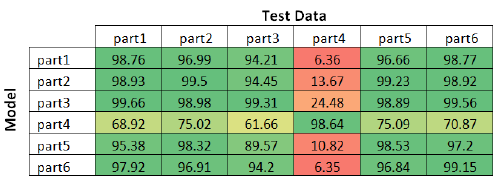
Figure 2. HEDVa grid scenario, with breakers and substation feeders